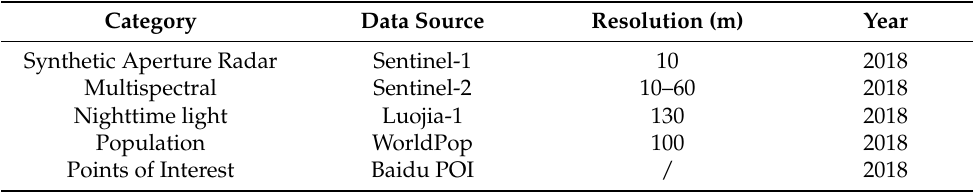
Table 3. An overview of datasets used for mapping urban land use.